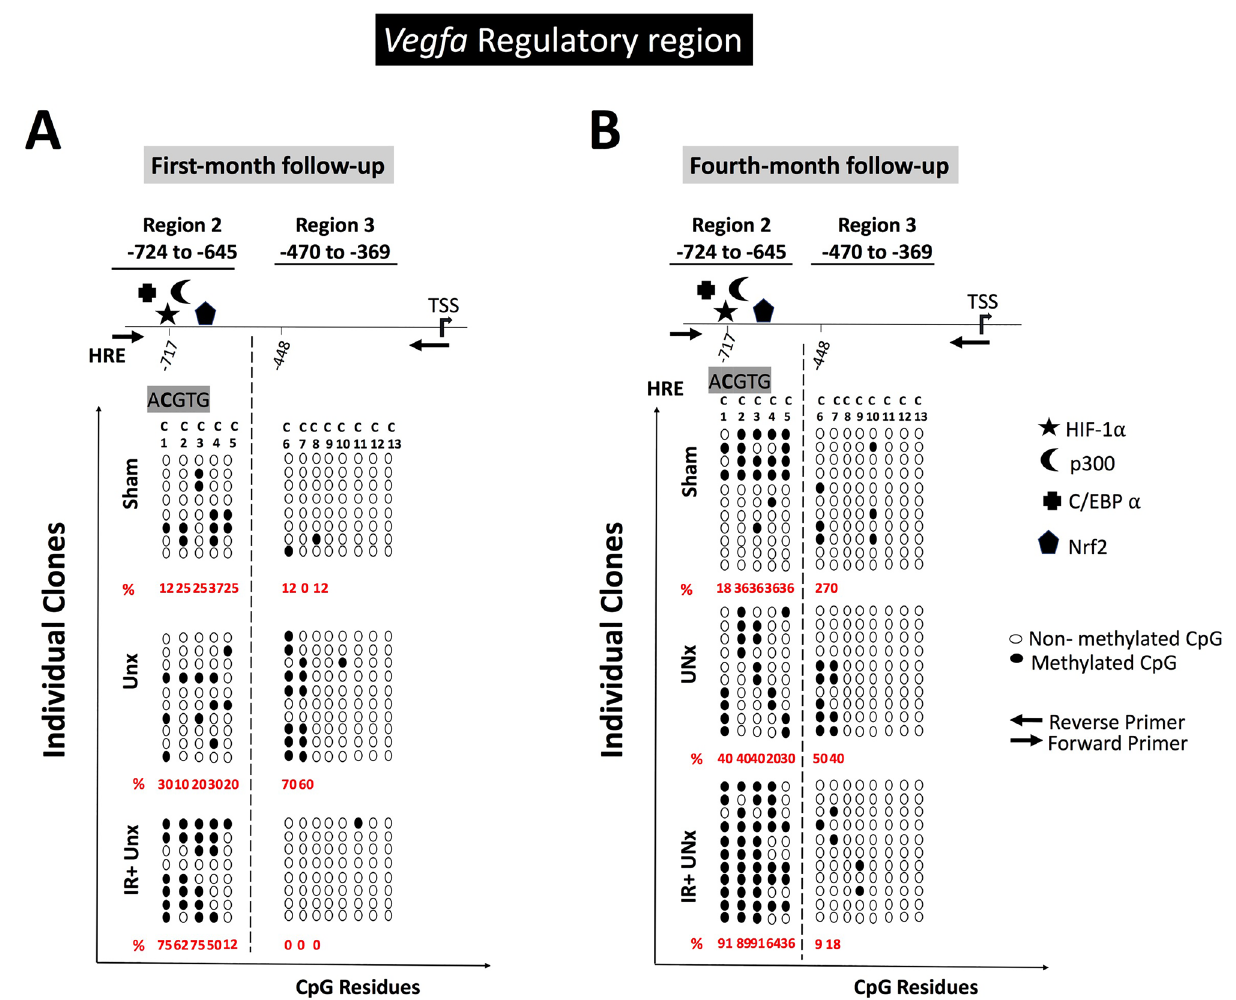
Figure 8. Bisulfite sequencing of two non-codifying upstream regions of Vegfa promoter for ( A ) the first- month and ( B ) the fourth month of follow-up for the Sham, UNx and IR + UNx groups, respectively. Arrows represented the forward and reverse primers for each amplicon. HIF-1α, p300, C/EBPα, and Nrf2 binding sites as is stated. White circles represented non-methylated CpG, and black circles represented methylated CpG, each circle represented an individual clone. Each C represented a cytosine in CpG context. TSS-Transcription star site; HRE-Hypoxia response element (PAS) or Sirius red. In the slices stained with PAS, ten microphotographs (Magnification 400x) were obtained from different renal cortex fields of each kidney and glomerular diameter was quantified in at least 40 glomeruli per rat using a Nixon camera incorporated to the microscope. In the slices stained with Sirius red, five to eight subcortical periglomerular fields per section were randomly selected in kidneys from the groups studied (Mag- nification 100x). Tubulo-interstitial fibrosis consisted of extracellular matrix expansion with collagen deposition together with distortion and collapse of the tubules; fibrosis was evidenced by red coloration in Sirus red-stained slides. The affected area was delimited and the percentage of tubulointerstitial fibrosis was calculated by dividing the fibrotic by the total area, excluding the glomerular area. Researchers were blind to the experimental group.